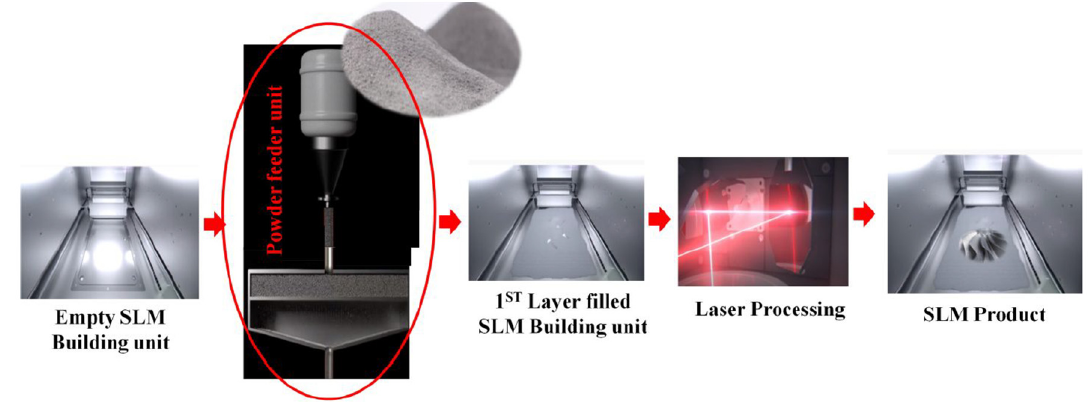
Figure 7. SLM process sequence in the building unit.